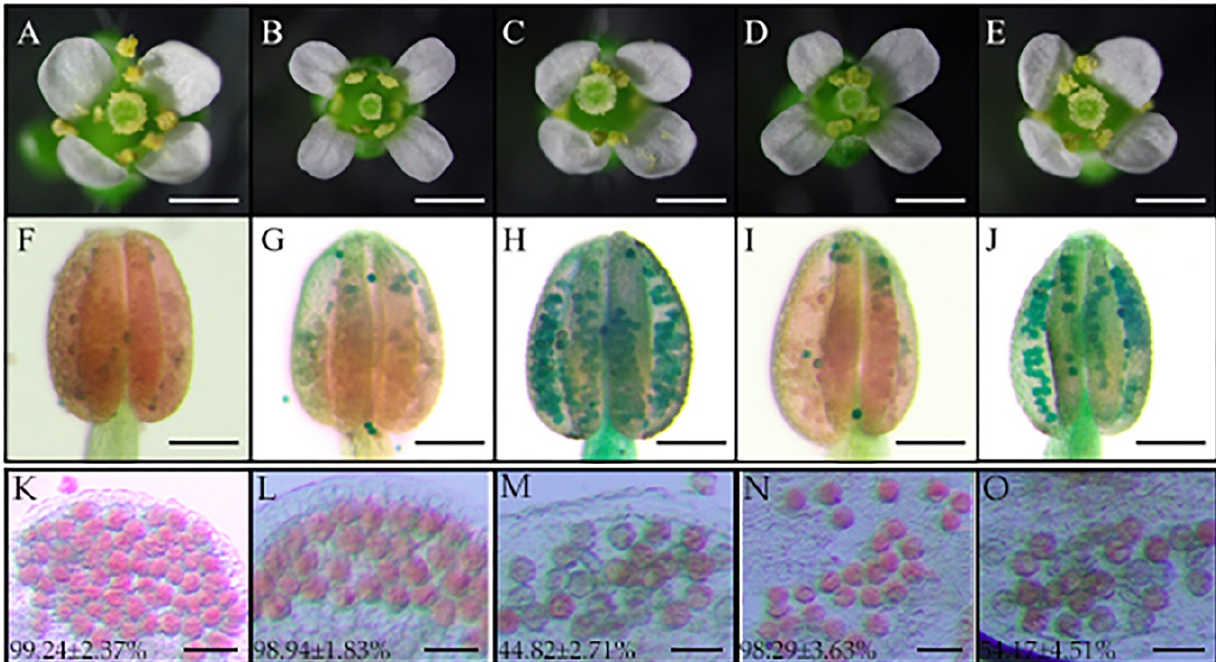
Figure 5. Phenotypic analyses of wild-type, TaTDRL-OE, TaTDRL-EAR, TaMYB103-OE, and TaMYB103-EAR transgenic Arabidopsis plants. ( A – E ) Phenotypic analysis of flowers; ( F – O ) Alexander staining of a representative anther; ( A , F , K ) wild-type; ( B , G , L ) TaTDRL-OE; ( C , H , M ) TaTDRL-EAR; ( D , I , N ) TaMYB103-OE; ( E , J , O ) TaMYB103-EAR. Scale bars: 2000 µm in ( A – J ), 50 µm in ( K – O ). Data are presented as means ± SD of three technical replicates and three independent biological replicates.